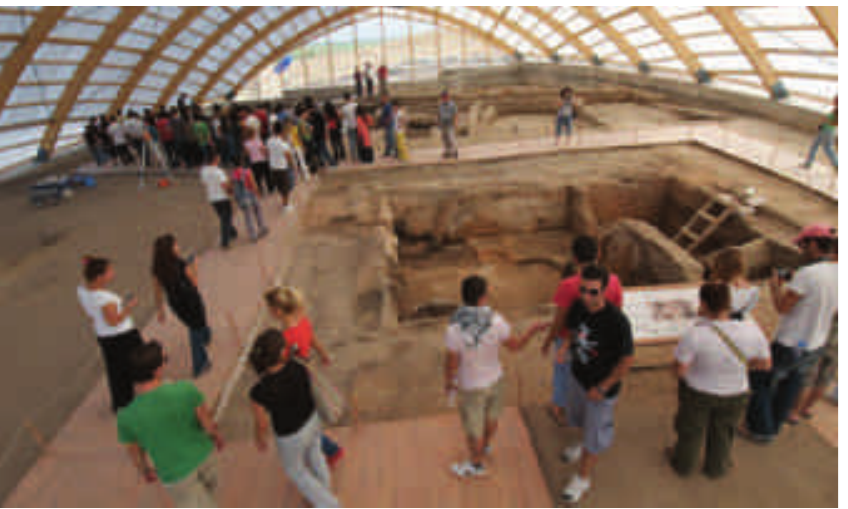
Figure 1 Looking down the length of the North shelter showing excavations and